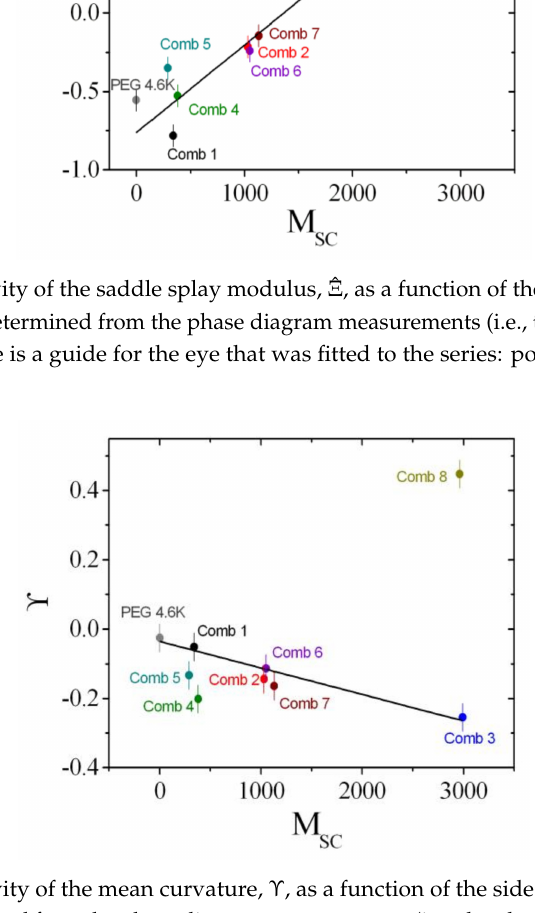
Figure 12. The sensitivity of the mean curvature, Υ , as a function of the side chain molar mass, M SC . The values are determined from the phase diagram measurements (i.e., the phase inversion temperature, (cid:101) T ). The line is a guide for the eye that was fitted to the series: PEG, Comb 1, 2, and 3. Comb 8 strongly diverges from the observed trends, both in terms of magnitude and